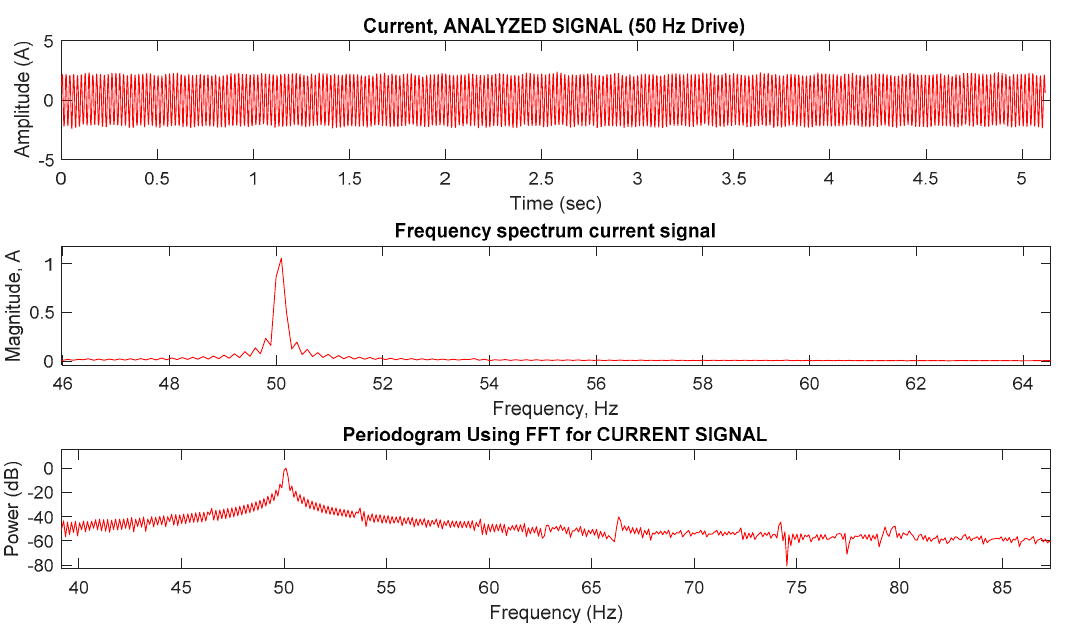
Figure 8. FFT analysis of current signal measurement of motor line current of phase A, frequency spectrum, and periodogram at 60 Hz speed operation.